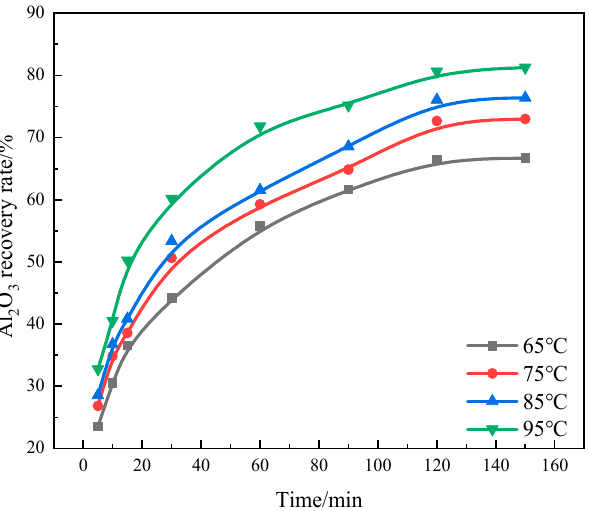
Figure 7. Plots of the leaching rate of Al 2 O 3 of the modified slag versus the leaching temperature and time.